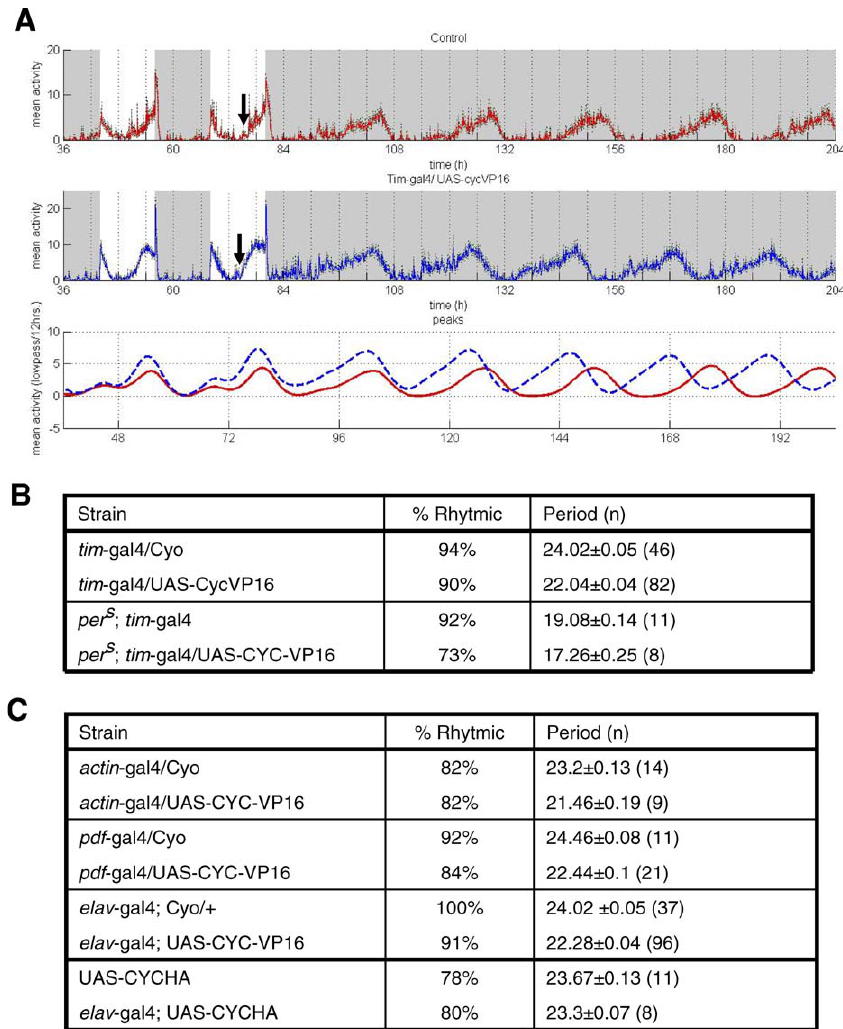
Figure 2. Expression of cyc - vp16 in Pacemaker Neurons Shortens the Period of Behavioral Rhythms (A) Comparison of circadian locomotor behavior of control flies ( uas - cyc - vp16 / þ , top tracing) and flies expressing cyc - vp16 under the control of the tim driver ( tim - gal4 / uas - cyc - vp16 , middle tracing). In each case, the behavior is shown in average actograms. The arrow indicates the phase of evening anticipation for each fly strain. The light timing is indicated by alternating white and gray background areas, with white representing the illuminated interval of the LD condition (ZT0–12) and gray representing the dark period (ZT12–24 and DD period). To facilitate the identification of peaks in the control and tim - cyc - vp16 datasets the data were smoothed with a low-pass filter set with a cutoff of 12 h (bottom tracing). (B) Period length of fly strains overexpressing uas - cyc - vp16 using the tim - gal4 driver and control flies. (C) Behavioral analysis of fly strains expressing the uas - cyc - vp16 or uas - cyc transgenes in combination with different gal4 drivers.